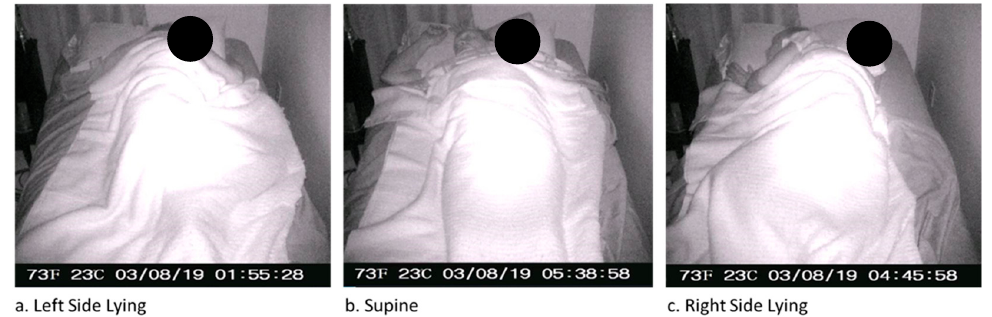
Figure 6. Graph of left-side lying, supine, or right-side lying classification mean F1 metrics for the LGB and XGB models across the four different incremental learning levels. The error bars represent standard deviation.